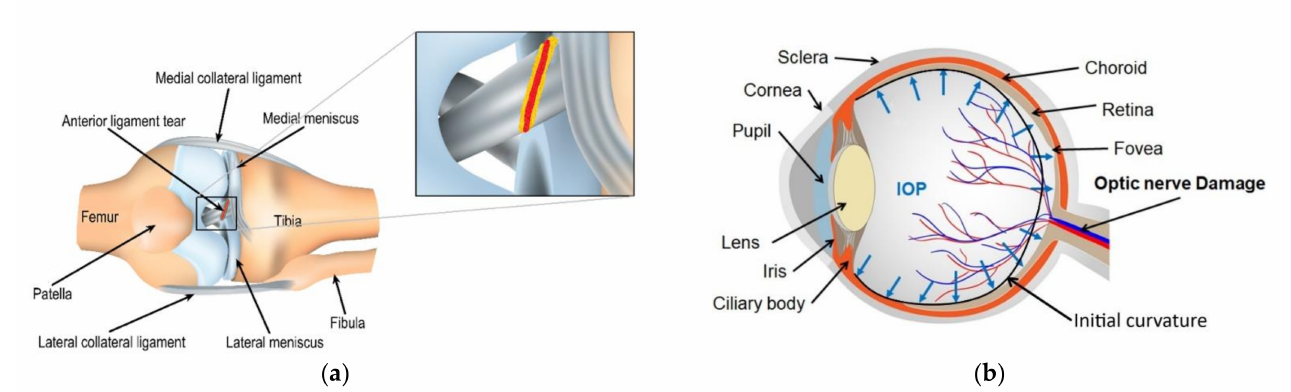
Figure 1. ( a ) Anterior cruciate ligament tear with the close view explaining the tear in the ligaments ( b ) Eyeball under